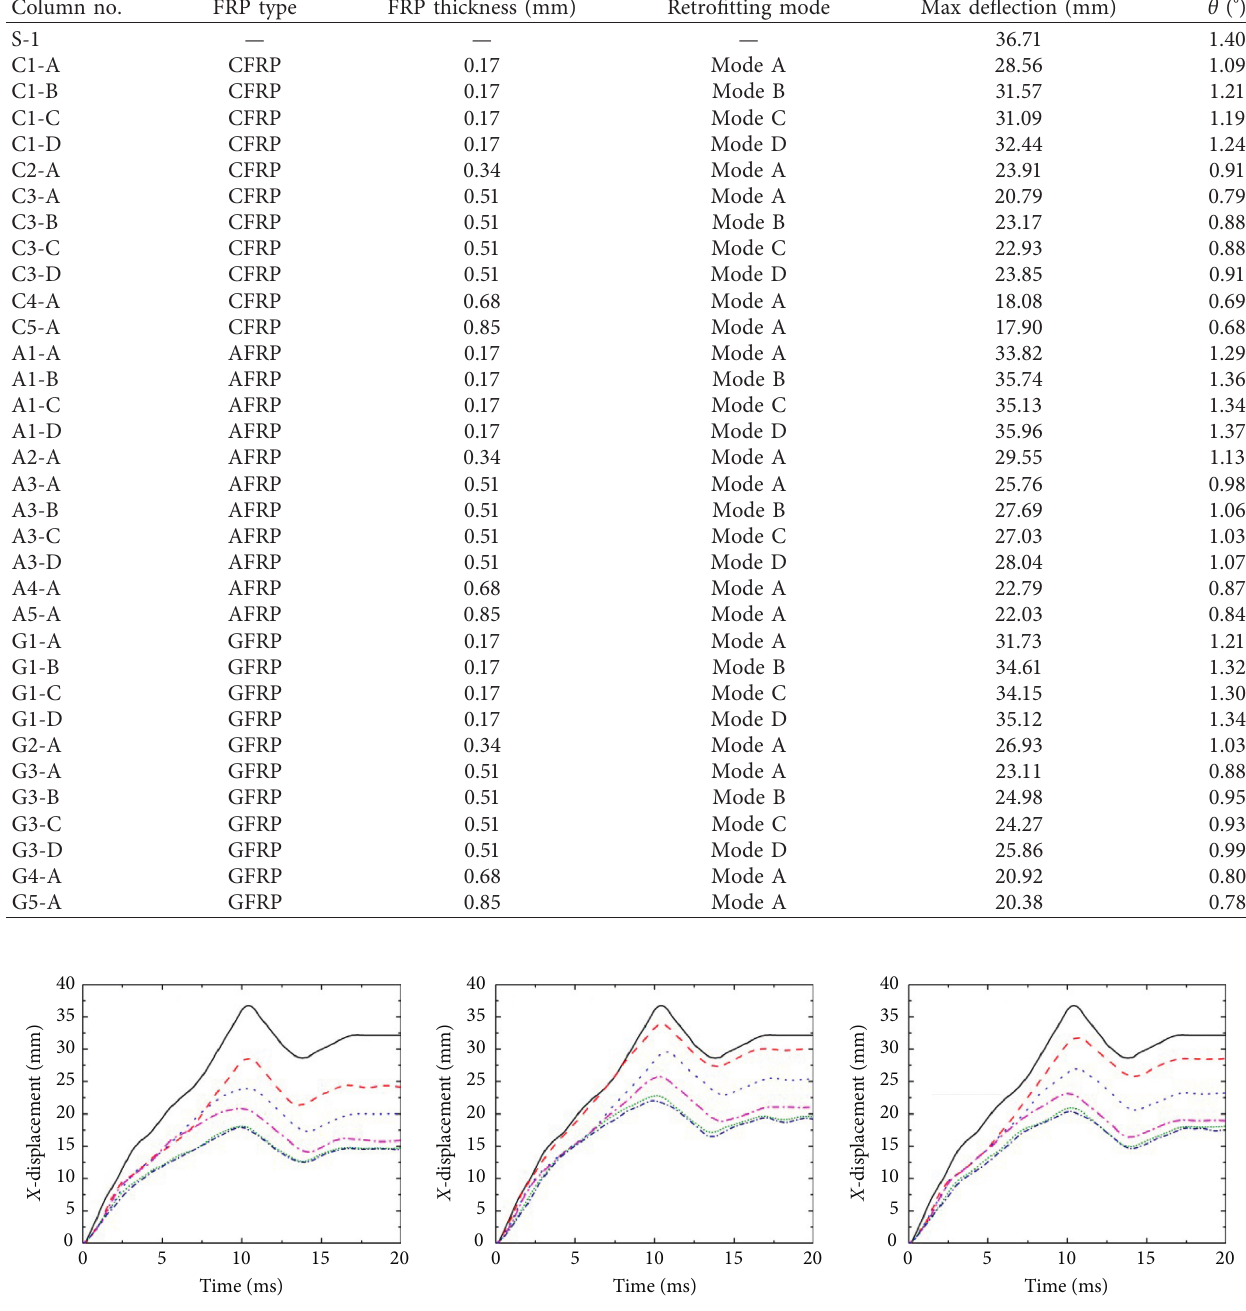
Table 5: Information and main results of investigated columns.